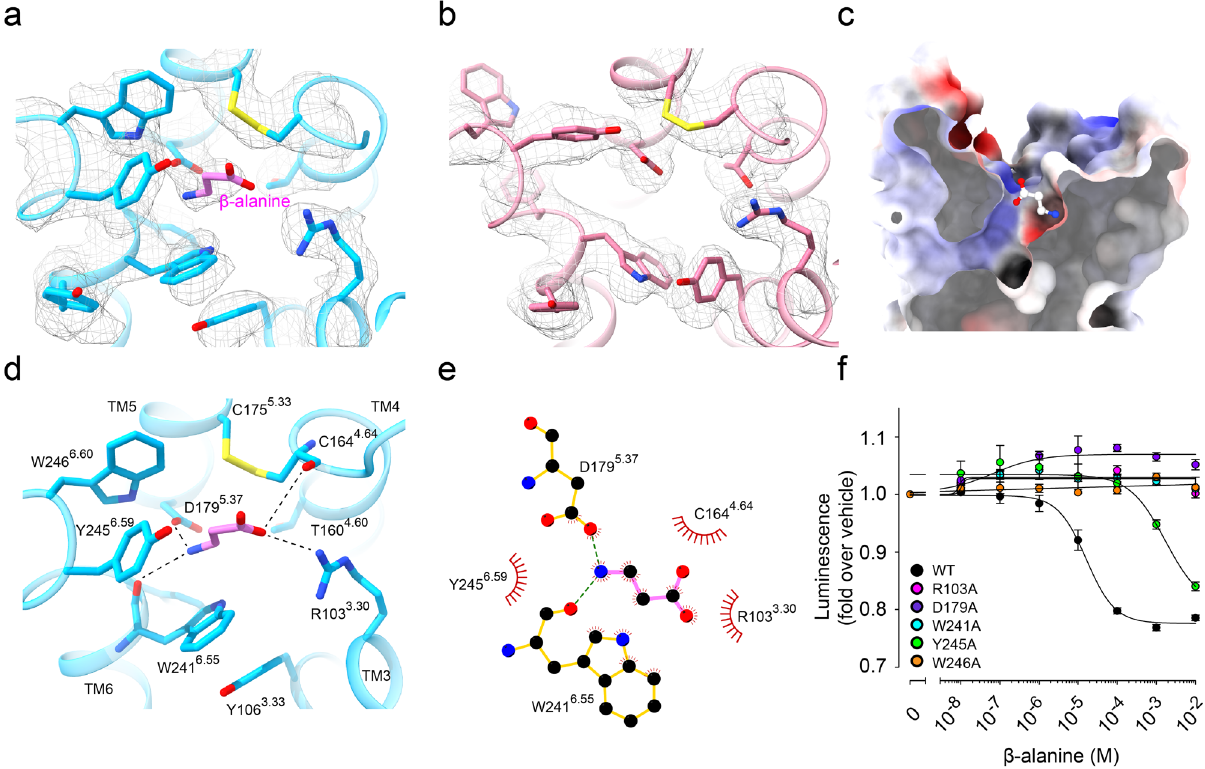
Fig. 2 Ligand recognition of MrgD. a , b Cryo-EM maps and models of the ligand-binding pocket of β -alanine ( a ) and apo MrgD ( b ) structures. The residues around the ligand-binding pocket and β -alanine are shown as stick models. The cryo-EM density maps are shown as a gray mesh. c Electrostatic surface potential of MrgD ligand-binding pocket in complex with β -alanine. β -alanine is shown as a stick model. d Ligand-binding pocket of β - alanine – MrgD. β -alanine and the side chains of MrgD contributing to ligand-binding are shown as stick models. Hydrogen bonds are shown as black dashed lines. e Schematic representation of β -alanine-binding interactions. Interactions were determined using LigPlot + . f MrgD-mediated Gi activation plot measured by the NanoBiT-G-protein dissociation assay. Dose – response curves are shown as means± s.e.m. (standard error of the mean) of six independent experiments for WT and three for the mutants. Data for the graphs in f are available as Supplementary Data 1.